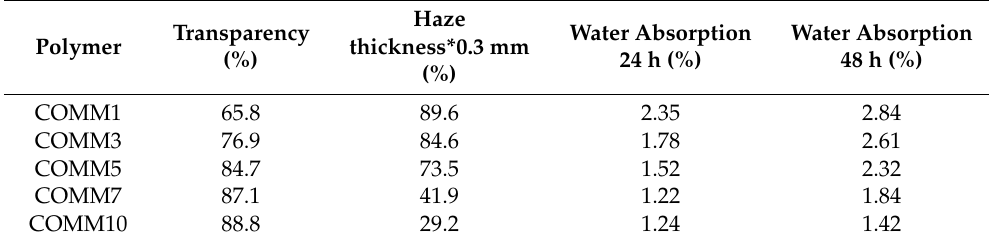
Table 6. Transparency and water absorption for PA6 containing Octadecadienoic acid and 4,4 (cid:48) -